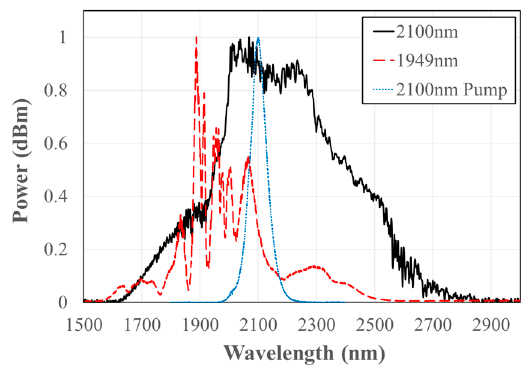
Figure 10. Comparison of normalized supercontinuum with the pumps at 1.949 µm (60 mm fiber) and 2.1 µm (65 mm fiber). The normalized pump spectrum of the 2.1 µm pump is also shown.